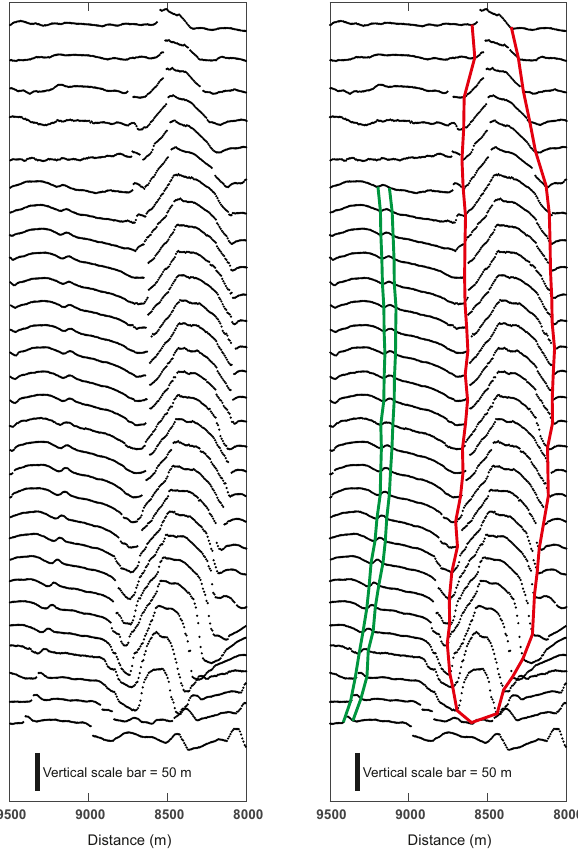
Figure 8. Elevation profiles from the crest of the central low ridge (Fig. 3) to illustrate the difference in cross section between parallel- sided MSGLs (highlighted in green on the right-hand panel) and tapering drumlins (highlighted in red). The drumlin tapers in width at both ends and has a maximum vertical relief an order of magni- tude greater than the